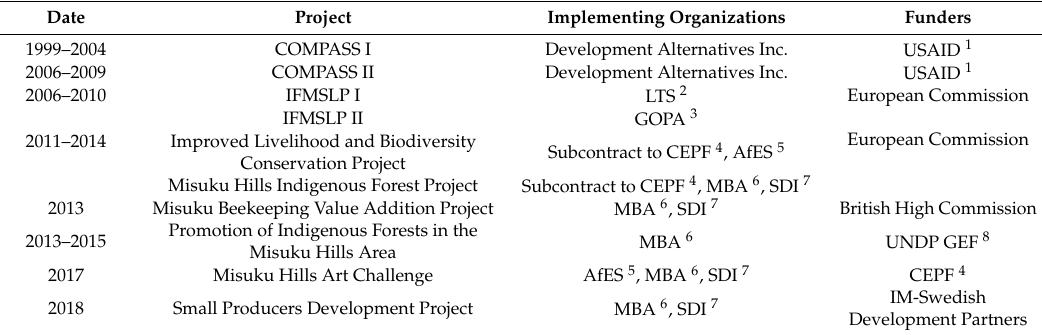
Table 2. Inventory of sponsored forestry conservation activities in the Misuku